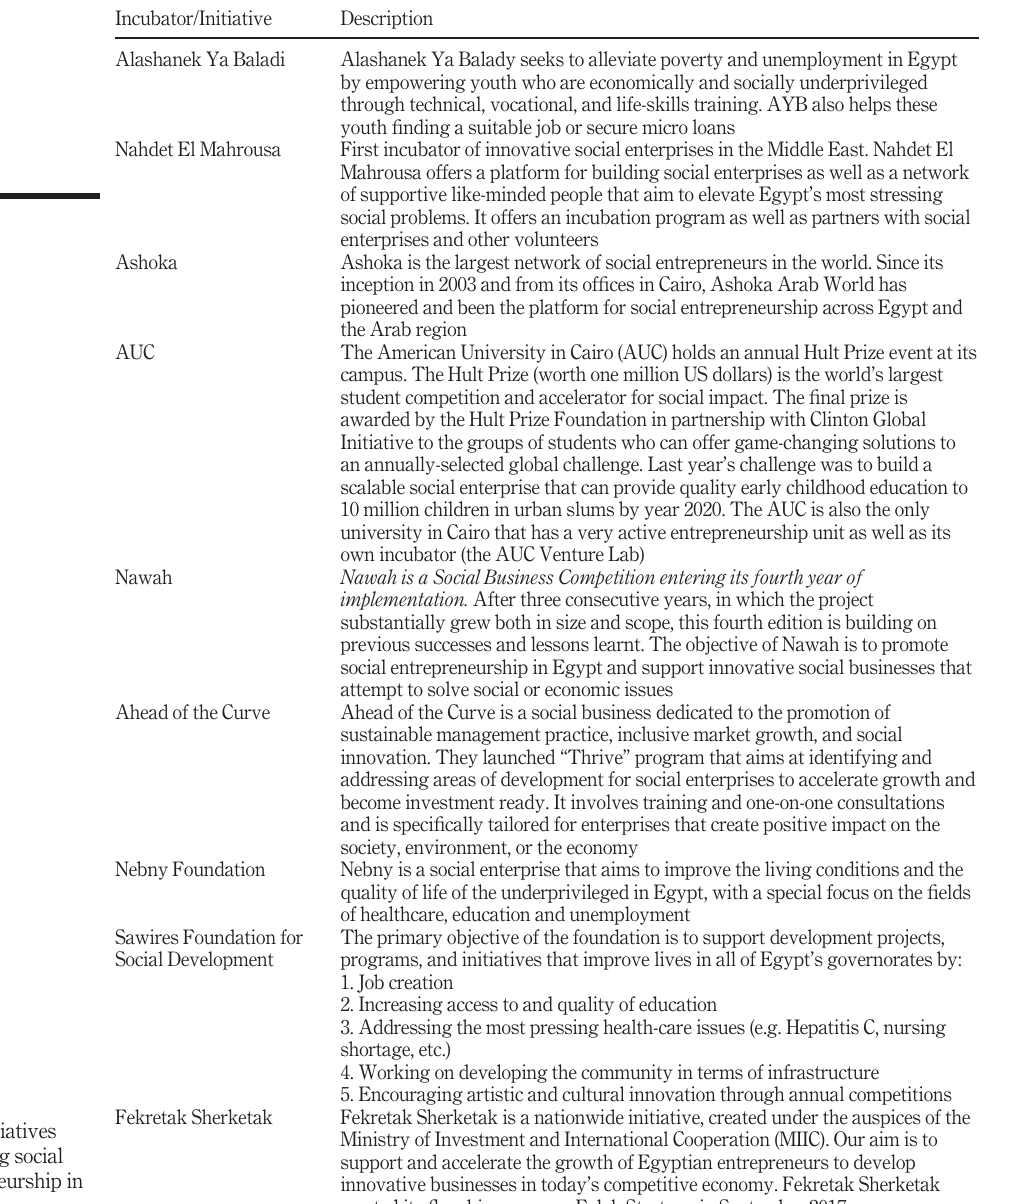
Table I. Major initiatives supporting